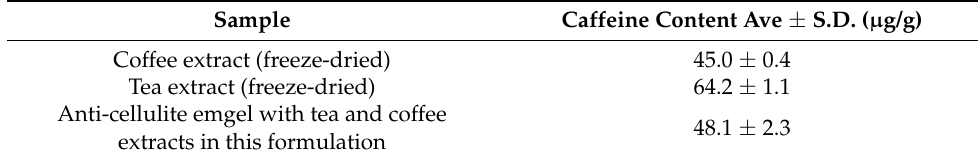
Table 8. The content of caffeine in the anti-cellulite emgel was analyzed by HPLC ( n = 3).